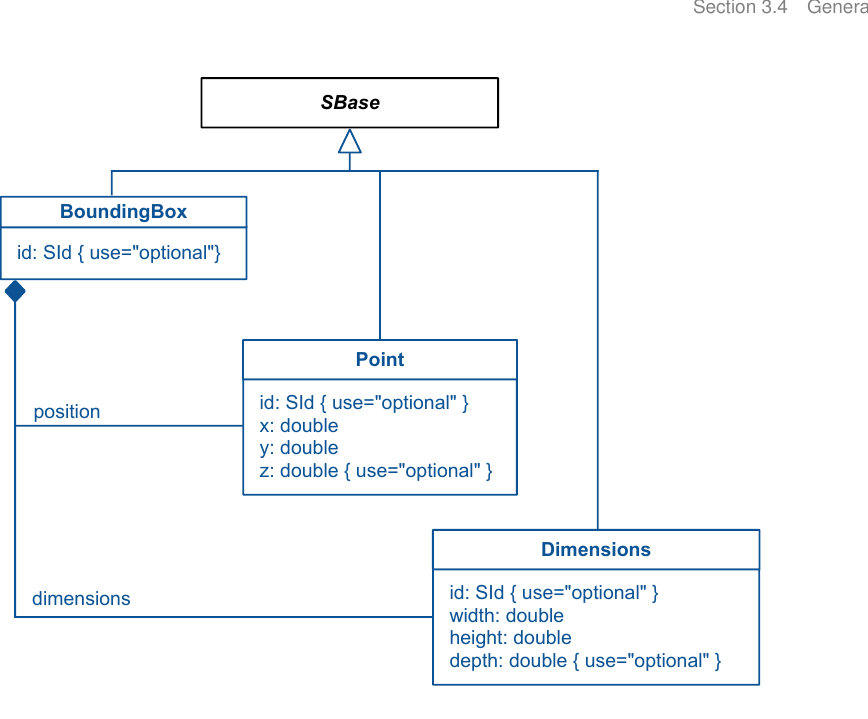
Figure 4: The definitions of the BoundingBox